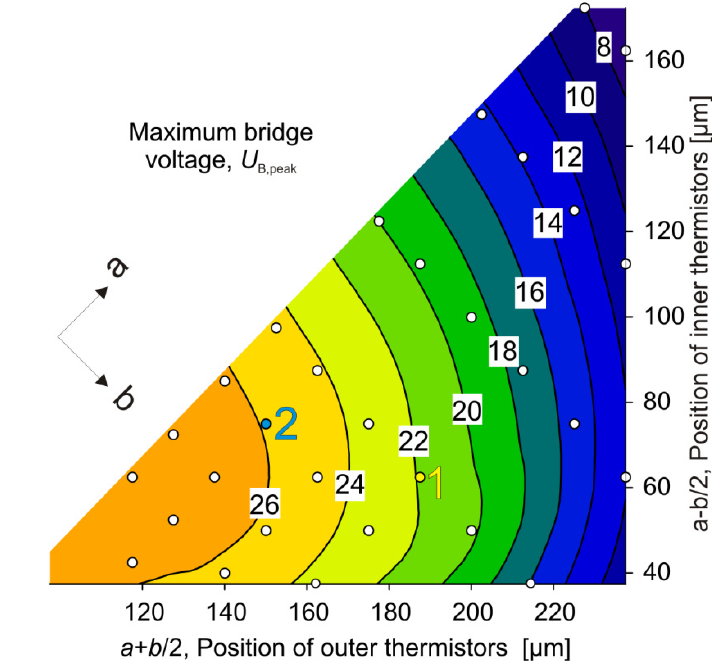
Figure 12. Contour plot of the maximum bridge detuning voltage simulated as a function of the inner and outer thermistor positions. For simulations the variables a and b were stepped. The arrows indicate the directions of increasing values of a and b